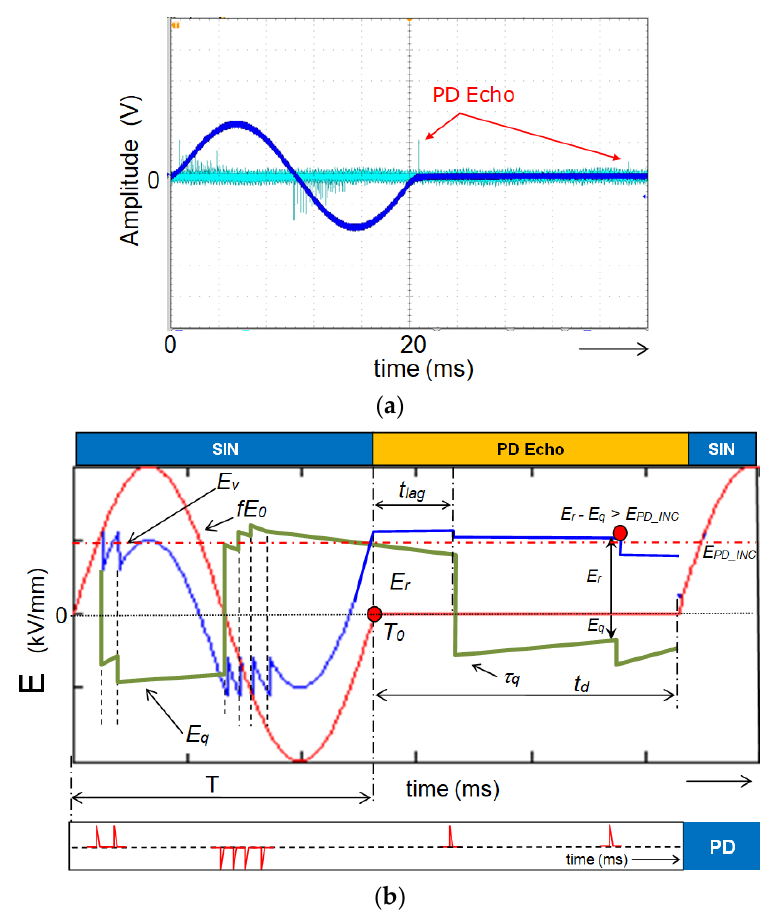
Figure 9. Multiple PD Echo mechanisms (without a PD pulse, prior to the transition point T 0 ), ( a ) exemplary individual PD Echo time-recording, ( b ) electric field waveforms.